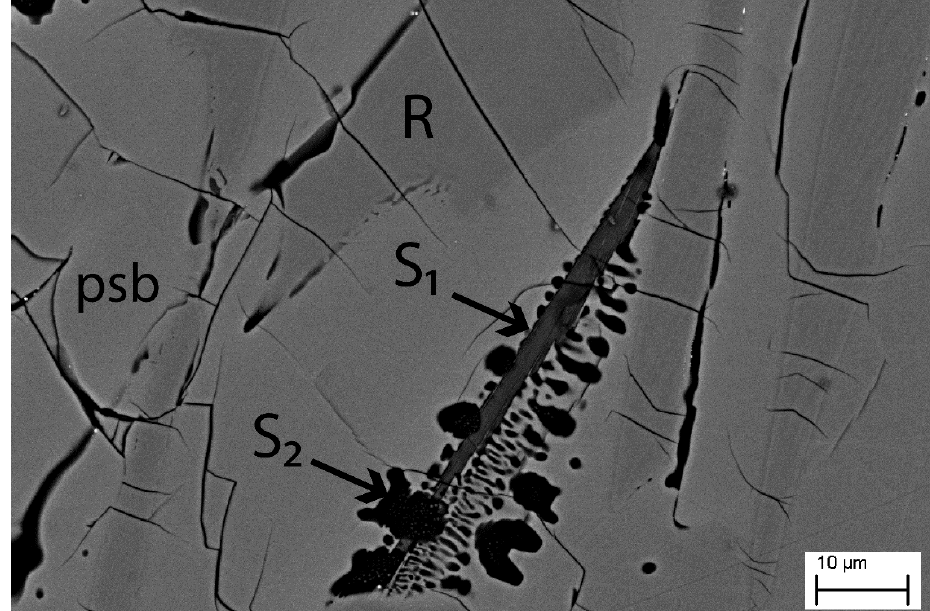
Figure 8. Microstructures of slag sample 3 analyzed by SEM. The silicate phase consisted of two different silicate phases, as represented by S 1 and S 2 , the lighter and darker silicate phases, respectively.